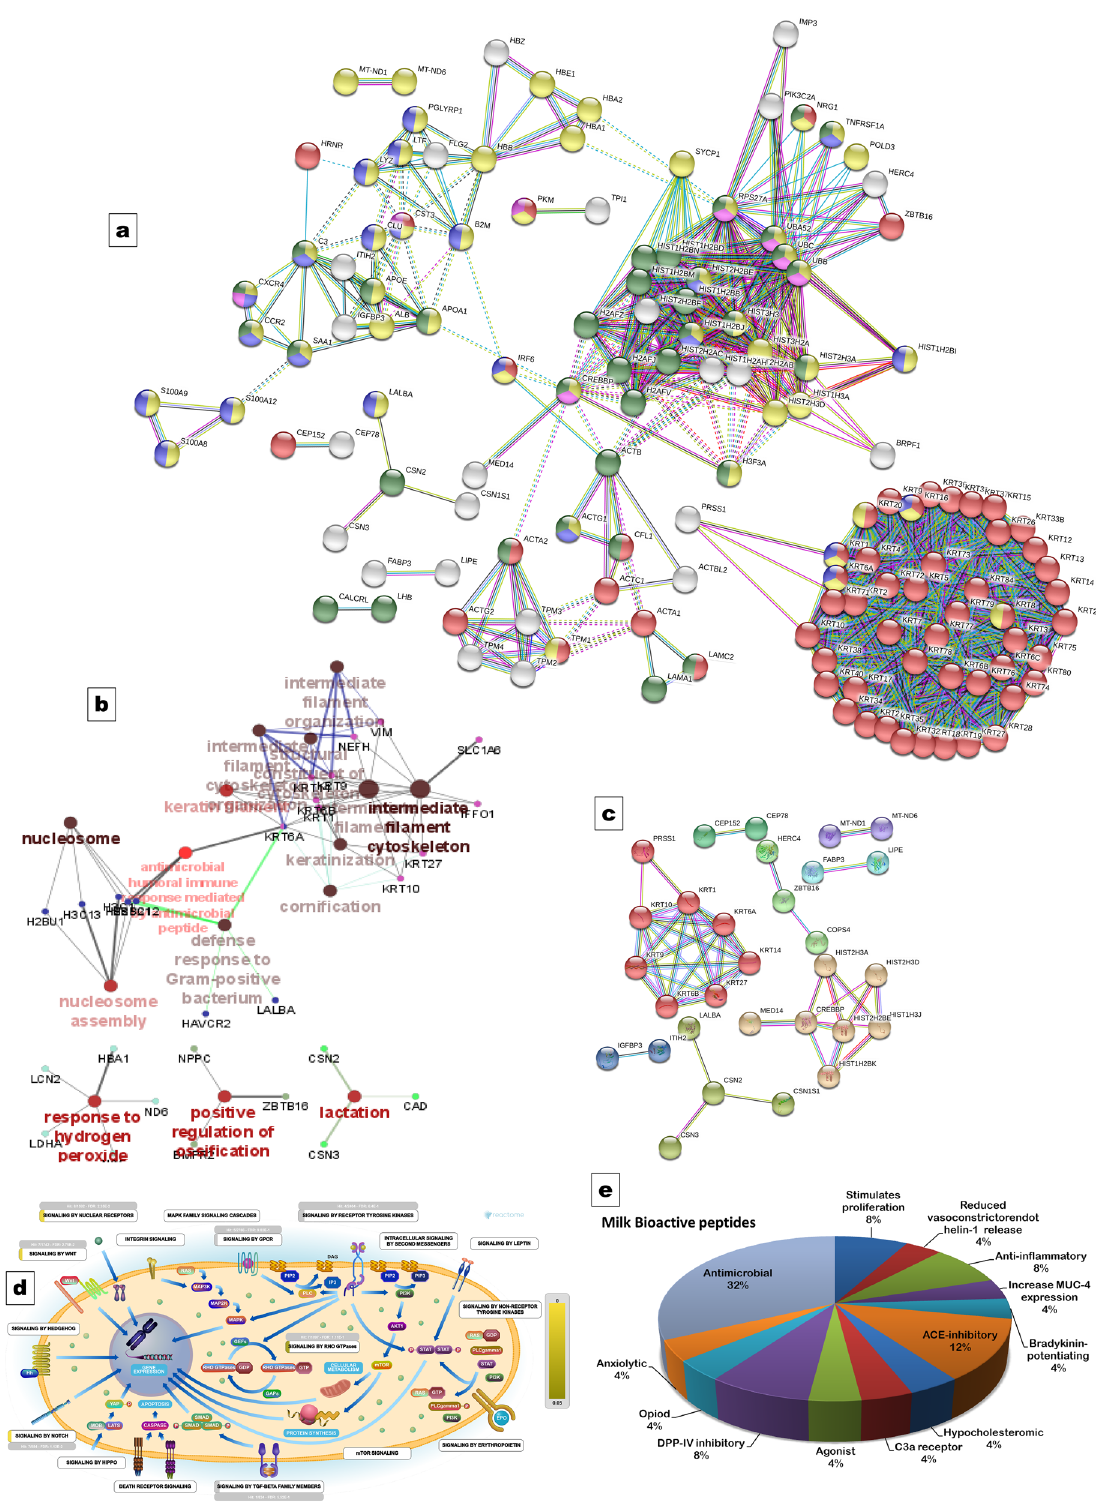
Figure 1. Functional prediction and protein-protein interaction analysis: MCL clustering by STRING for all the identified proteins ( a ); Cytoscape network analysis of PTM gene subset ( b ); MCL clustering by STRING for PTM protein subset ( c ); Signal transduction pathway from reactome database for PTM protein subset ( d ); functional attributes of identified bioactive peptides ( e